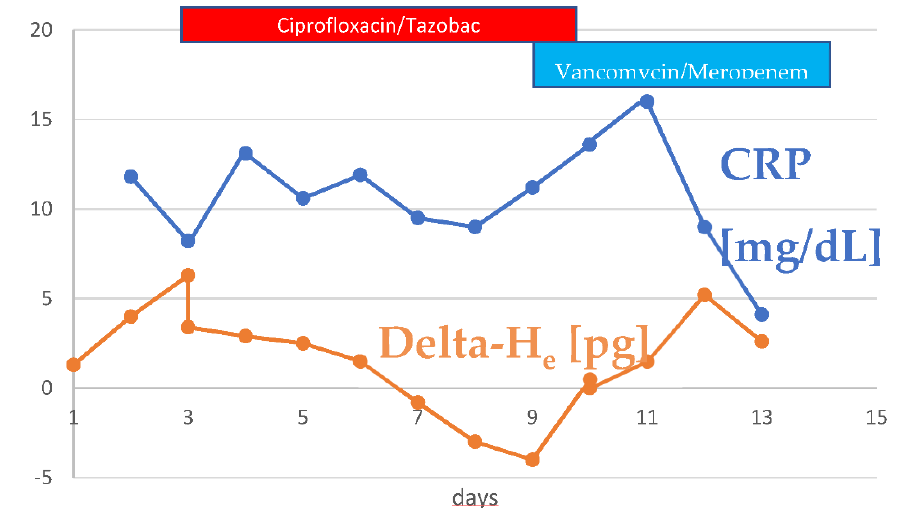
Figure 3. Example for Delta-He in a sepsis patient. The response to a change in antibiotic therapy is already apparent in the increase in Delta-He after 12 h - Other parameters respond much more slowly.